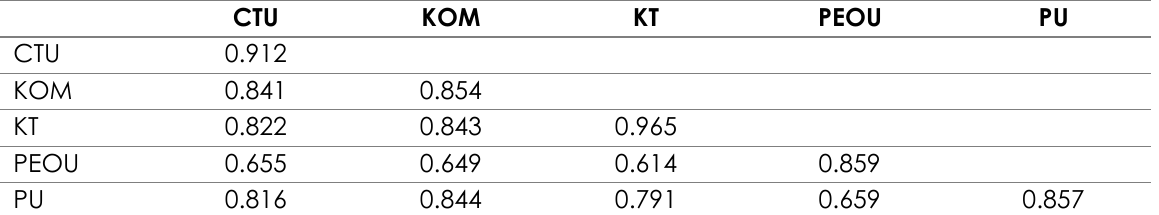
Value of Discriminant Validity (Fornell-Larcker